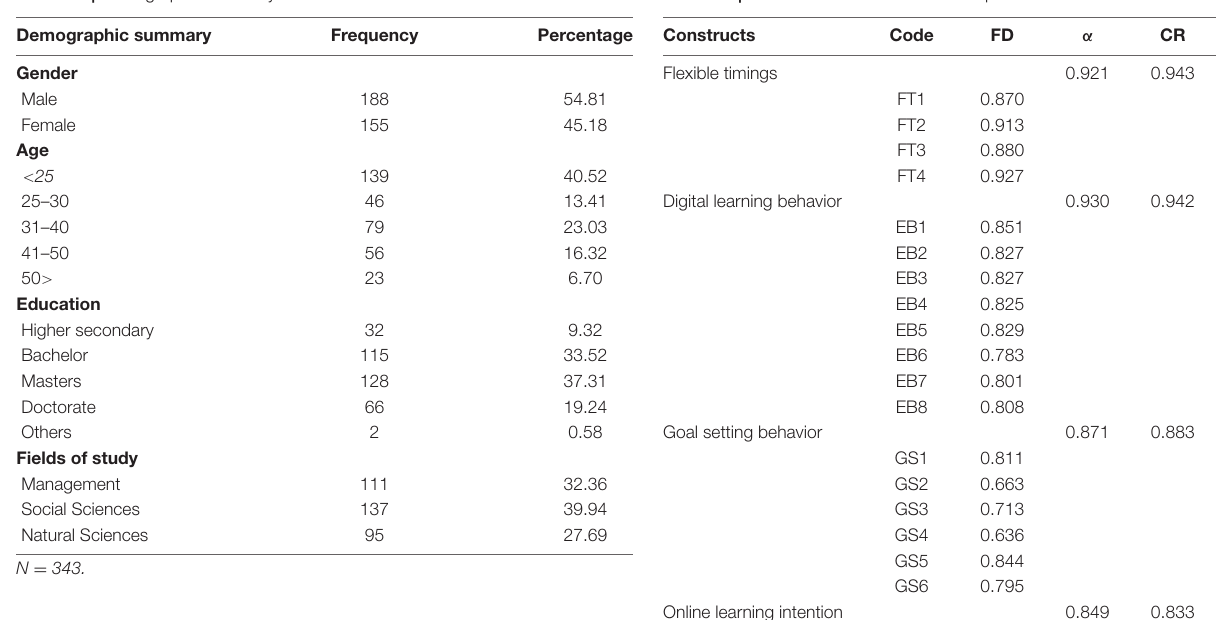
TABLE 1 | Demographic summary. TABLE 2 | Measurement model and descriptive